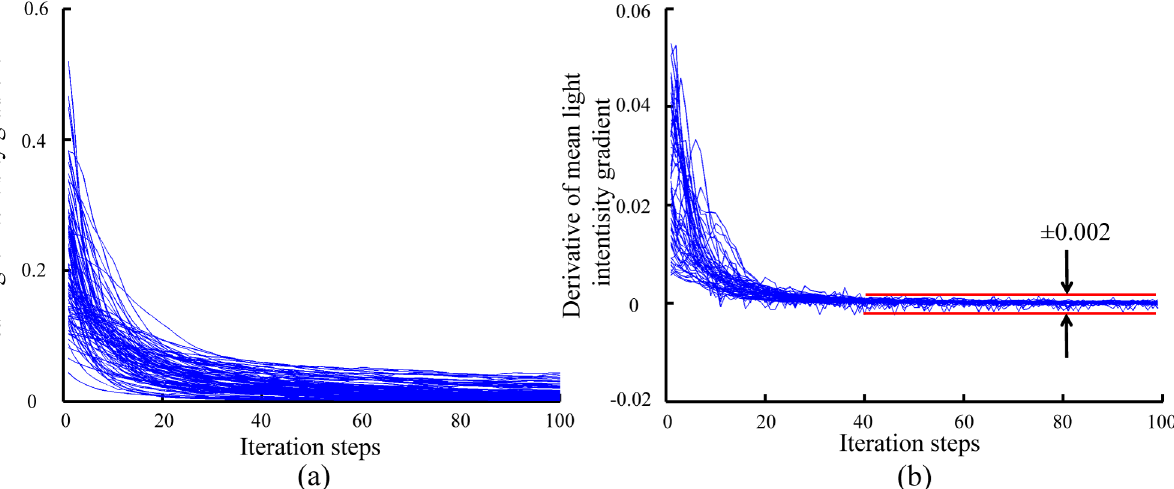
Fig 4. (A) Variation of the mean light intensity and (B) its time derivative along detected contours during contour expansion. The mean light intensity gradient decreases with time and mostly reaches its steady state value after about 40 times iteration. The time derivative of the mean light intensity was used as the termination condition for the